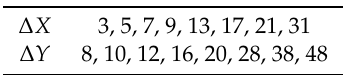
Table 2. List of distributions